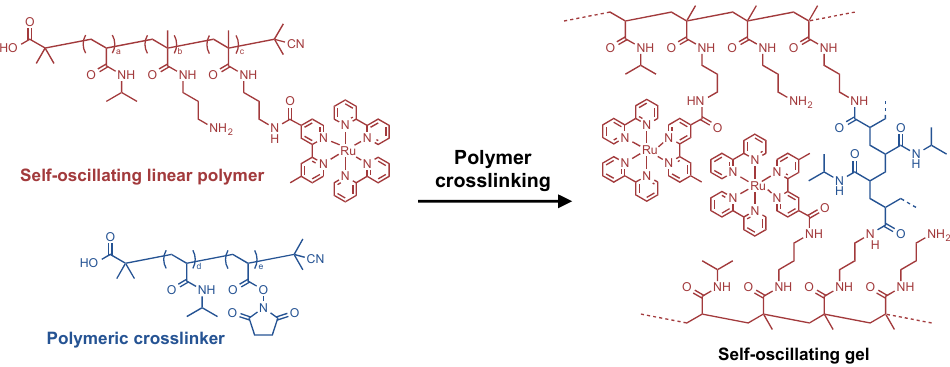
Figure 1. Conceptual scheme of polymer crosslinking method for fabricating self-oscillating gels.